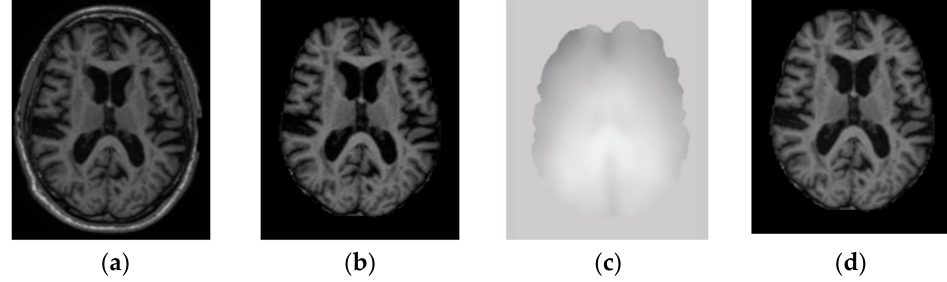
Figure 3. Pre-processing of MRI. ( a ) T1-W original MRI, ( b ) Brain tissue image after removal of the nonbrain structure, ( c ) The bias field, ( d ) Brain tissue image after bias field correction. Brain extraction: Brain MRI shows tissue as well as parts of the head, eye, fat, spinal cord,